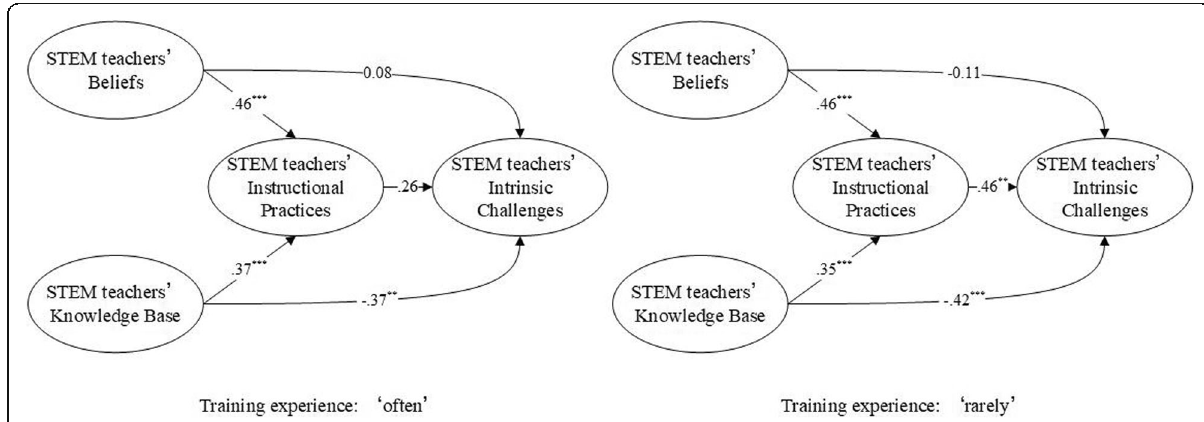
Fig. 3 The structural model with standardized coefficients based on the experience of STEM